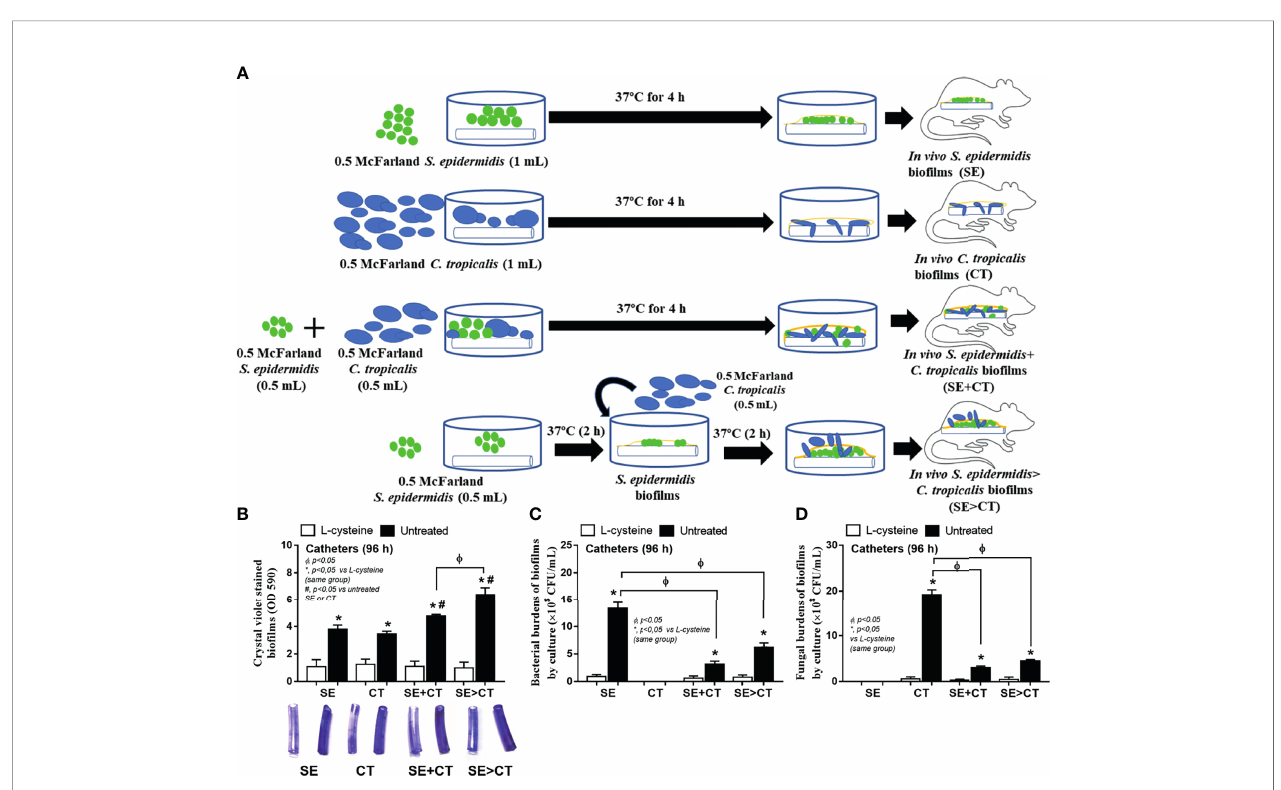
FIGURE 6 | Schema of the in vivo experiments for the subcutaneous implantation of catheters with bio fi lms from Staphylococcus epidermidis (SE), Candida tropicalis (CT), SE simultaneously mixed with CT (SE + CT), and preformed SE bio fi lms following CT (SE > CT) (A) demonstrated. Characteristics of mice with subcutaneously implanted catheters with L -cysteine or untreated groups as determined by bio fi lms in catheters (intensity of crystal violet color) (B) and microbial burdens by culture (bacteria and fungi) in bio fi lms (C, D) (n = 7 – 9/group) are